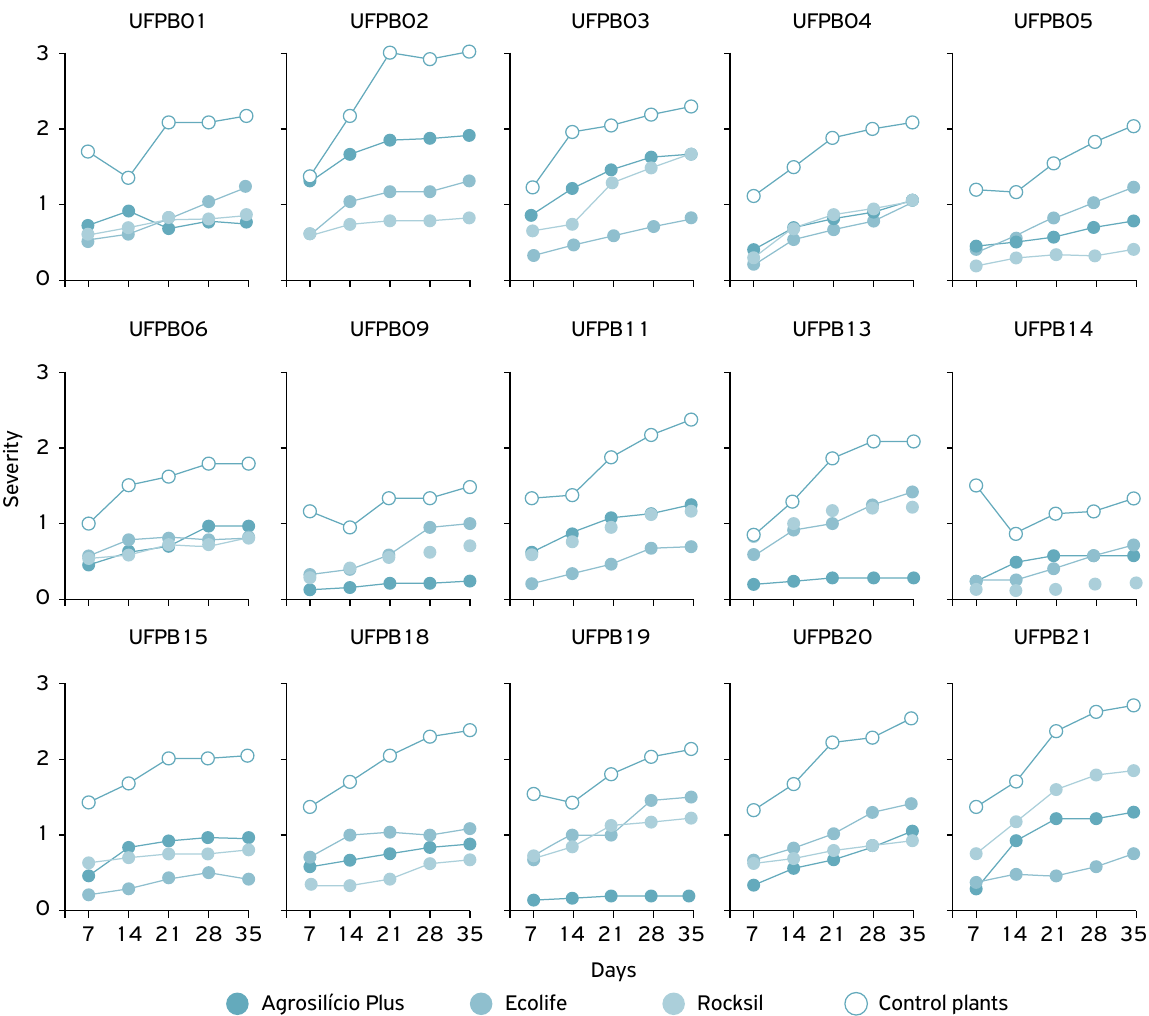
Figure 2. Effect of treatments with resistance inducers on the reduction of anthracnose severity in lima bean accessions ( Phaseolus lunatus L.) grown under conditions